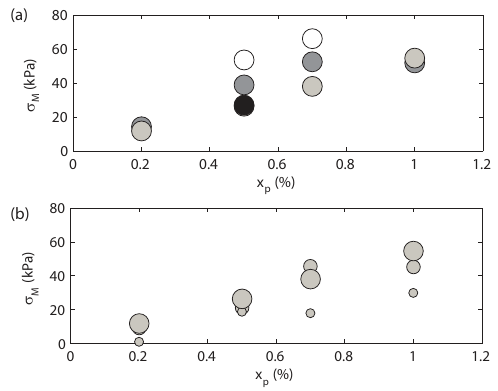
Figure 4. Macro-scale tensile stress σ M as a function of the para ffi n content x p . (a) Large device with d = 1.4 mm (white), d = 3 mm (grey), d = 4 mm (dark grey), and d = 7 mm (black). (b) Large, medium and small devices (symbol size) with d = 3 mm.